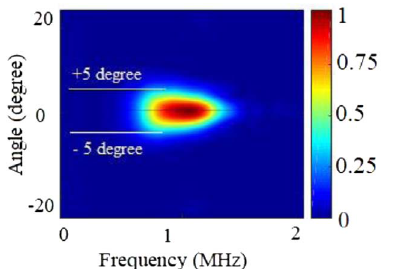
Figure 4. The normalized angular spectrogram was obtained from a polar scan on a smooth surface, indicating beam divergence measurement using the intensity of 10 (in the color bar) as a threshold.